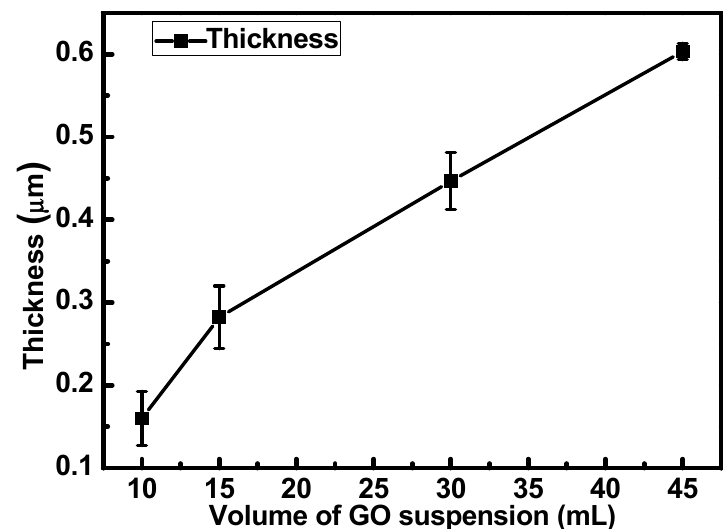
Figure 2. Thicknesses of GO films obtained from various volumes of GO suspension.